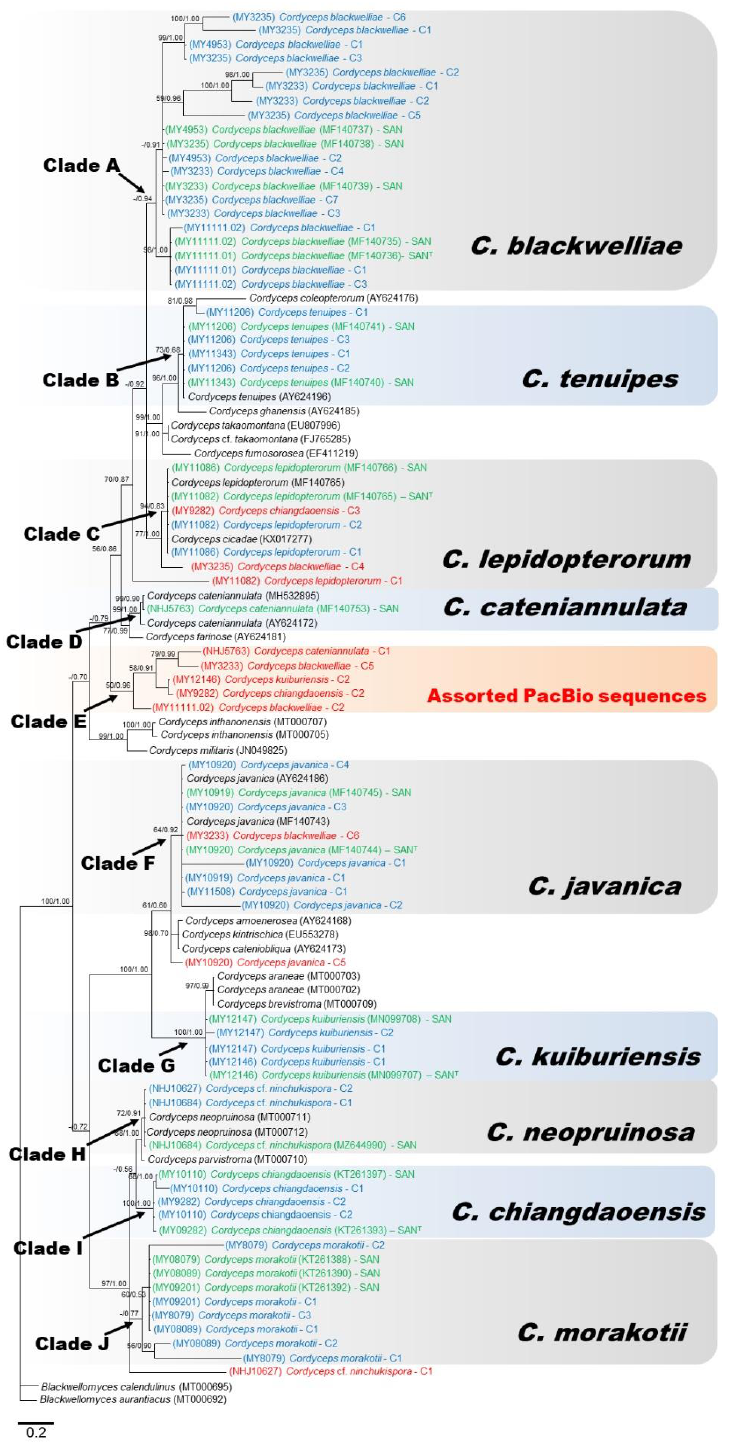
Figure 2. Consensus phylogram (50% majority rule) from a Bayesian analysis of the nrITS sequences, obtained from 10 6 MCMC generations. Maximum likelihood bootstrap values >50% (left of/) and Bayesian posterior probabilities >0.50 (to the right). The scale bar represents substitution rate per site. The PacBio cluster sequences highlighted in blue are those clustered within corresponding true species clades; other PacBio cluster sequences highlighted in red are those branched outside the species of origin. All Sanger sequences of the studied strains are highlighted in green. Sanger sequences of type species demarked as